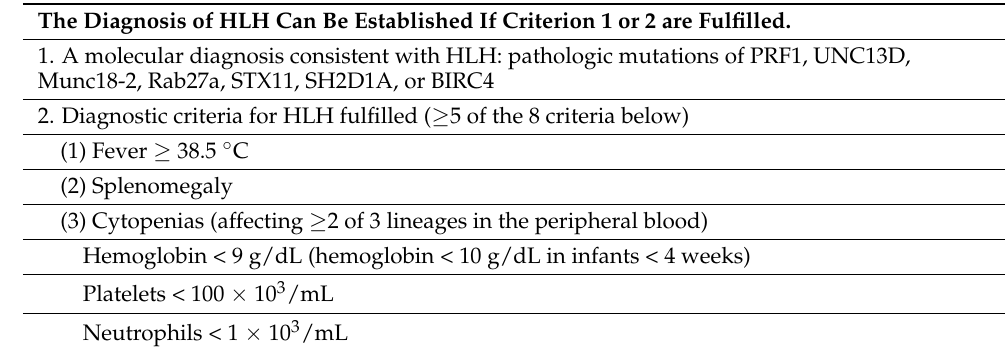
Table 2. HLH-2004 diagnostic